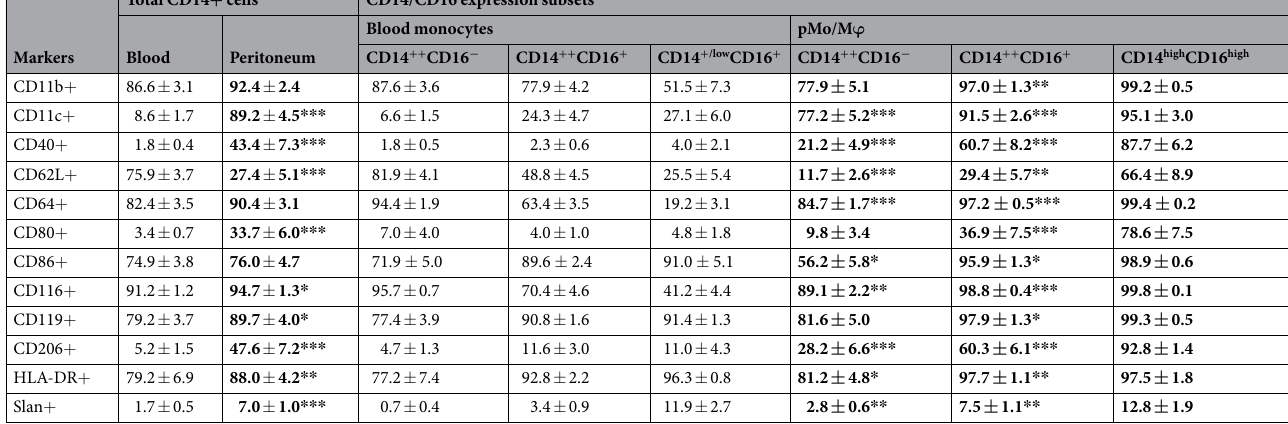
Table 2. Phenotypic profile of total pMo/M ϕ and CD14/CD16 subsets compared to blood of healthy humans. Data represent the Mean ± SEM percentage of positive cells for every membrane marker analyzed. * p < 0.05, ** p < 0.01, and *** p < 0.001 between percentages of positive pMo/M ϕ CD14 ++ CD16 − and CD14 ++ CD16 + cells compared to their blood equivalent subsets.